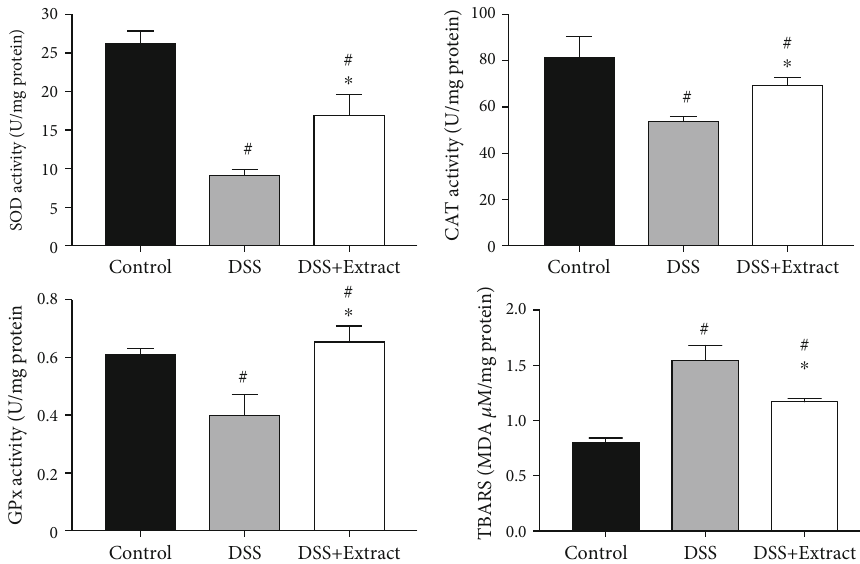
Figure 6: E ff ects of the C. procera methanolic extract on the enzymatic activity of SOD, CAT, and GPx, and the MDA levels during DSS- induced colitis. Determinations were made in homogenized colon tissue. The data are presented as the mean values per group ( n = 6 ). ∗ represents signi fi cant di ff erences vs DSS group ( P < 0 : 0001 ) and # P < 0 : 0001 vs Control group (one-way ANOVA).